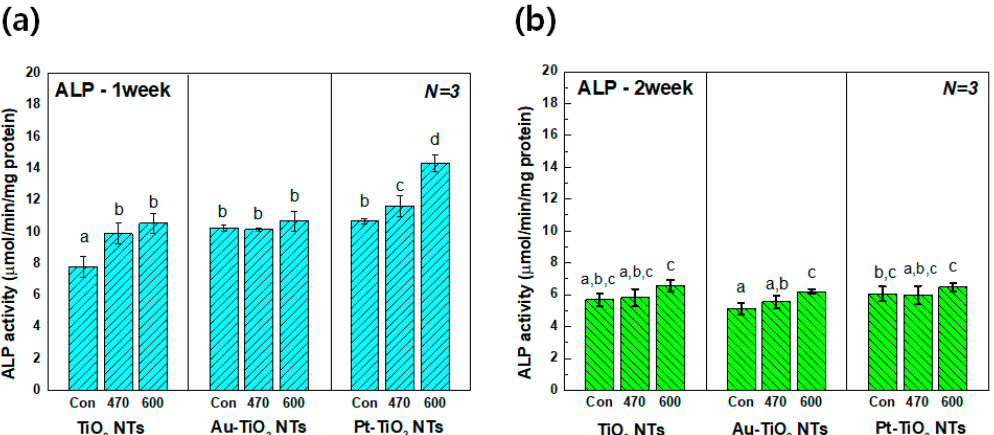
Figure 8. Alkaline Phosphatase (ALP) activity of hMSCs cultured on TiO 2 NTs, Au–TiO 2 NTs, and Pt–TiO 2 NTs after ( a ) 1 week and ( b ) two weeks of incubation (“Con”: No irradiation, “470”: 470 nm irradiation, “600”: 600 nm irradiation) (in each graph, entries with the same uppercase and lowercase letters were not significantly different as determined by one-way ANOVA at α = 0.05).